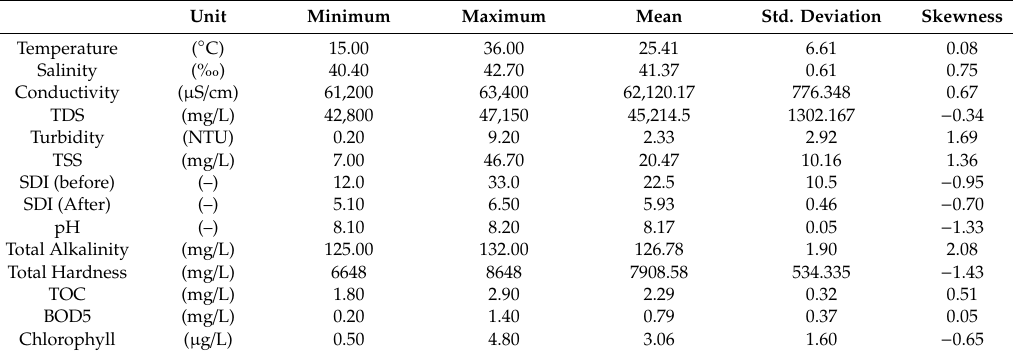
Table 5. Descriptive statistics of water quality parameters for intake gulf